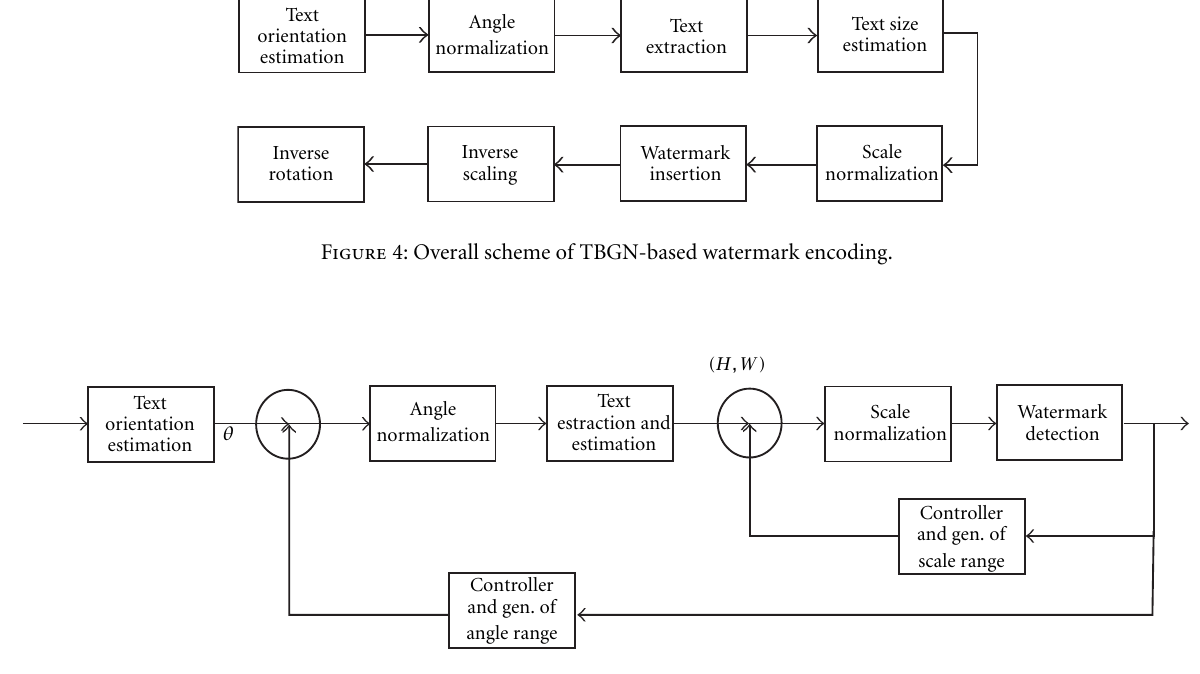
Figure 5: Overall scheme of TBGN-based watermark